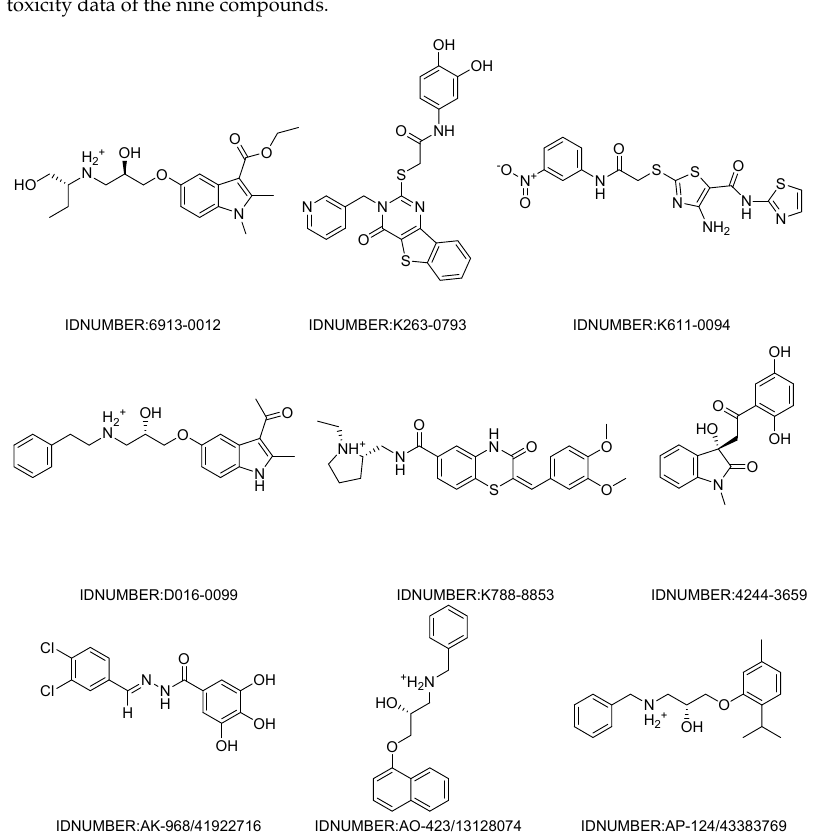
Figure 1. The virtual screening workflow.